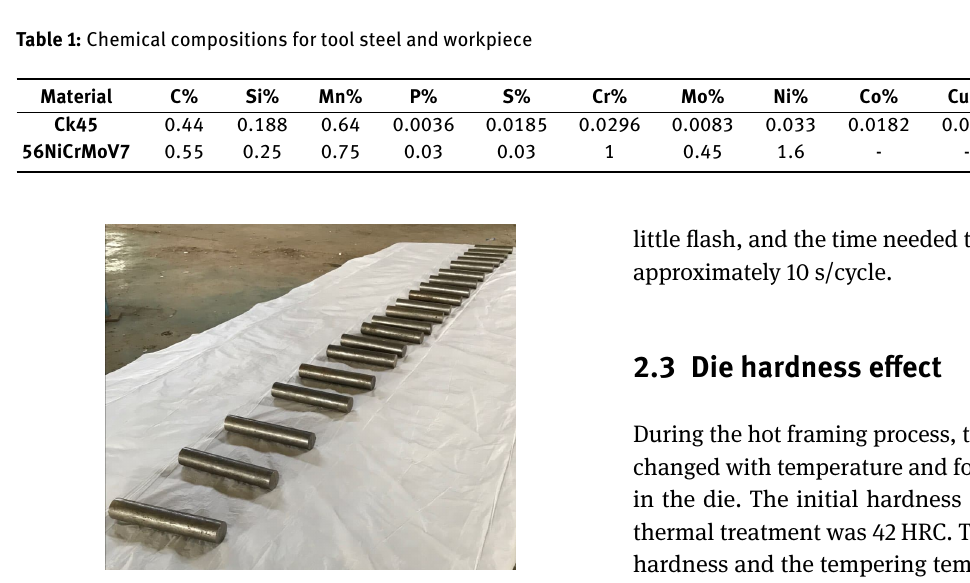
Figure 1: Billets of Ck45 prepared with dimension (30 ∅ × 160 L) mm